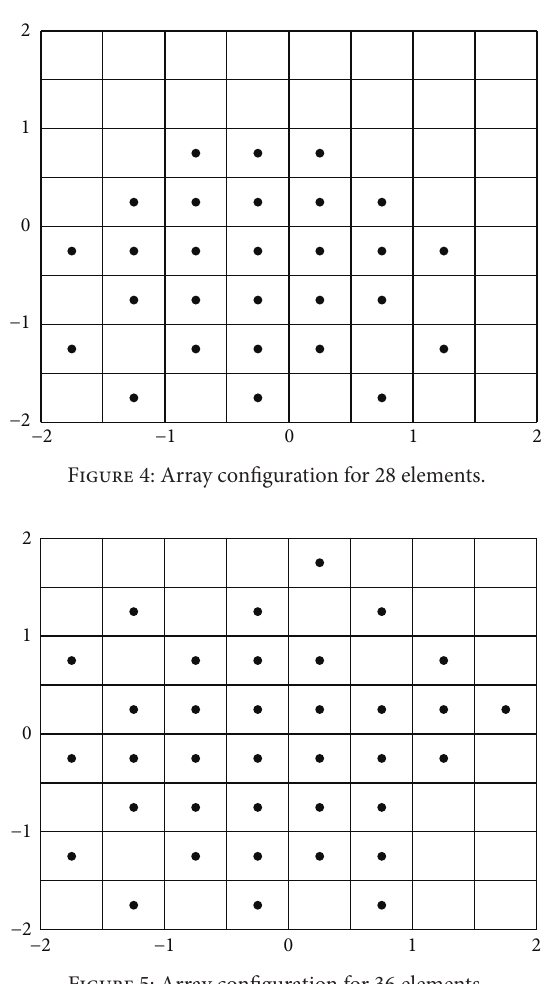
Figure 7: Array configuration for 78 elements.